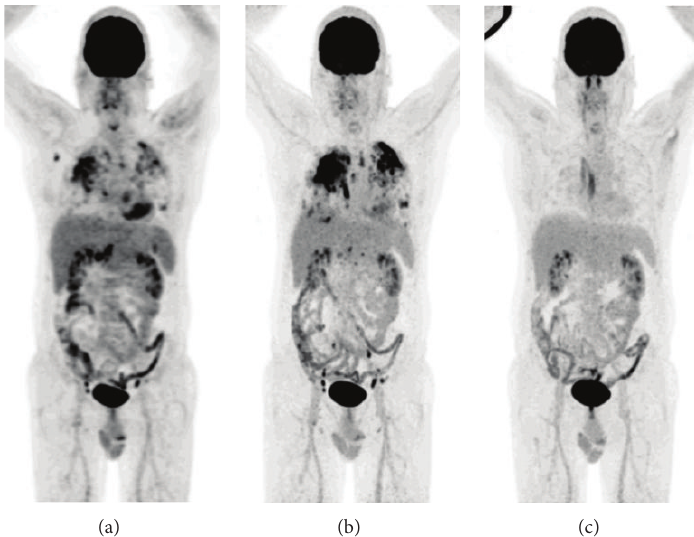
Figure 3: An example of the value of FDG-PET/CT in a patient with sarcoidosis: (a) baseline scan, (b) scan after 3 months of corticosteroid therapywithprogressionoflunginfiltration,and(c)scanafter3monthsoftreatmentwithcorticosteroidsandmethotrexatetogether,resulting in complete remission (the linear uptake is located in a muscle in the back and considered physiological muscle